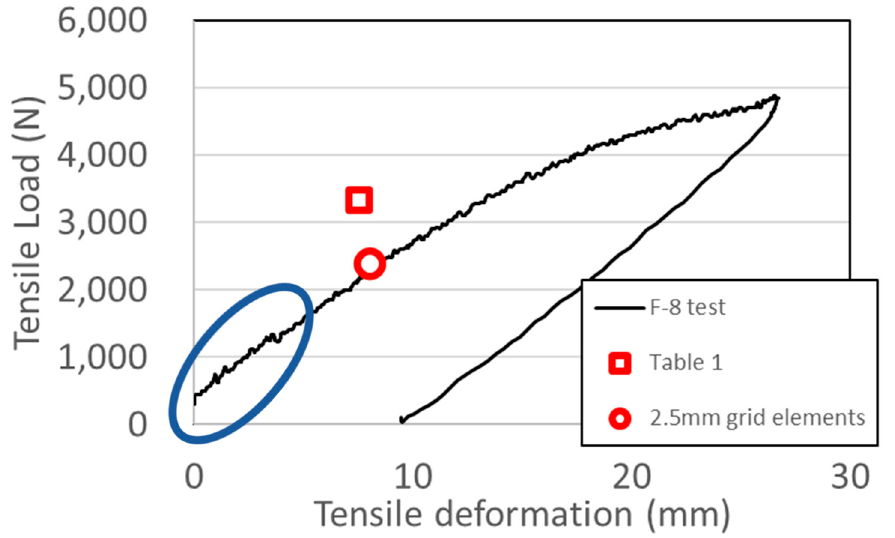
Figure 6. Relationship between tensile deformation and tensile load for F-7 specimen. Handle A